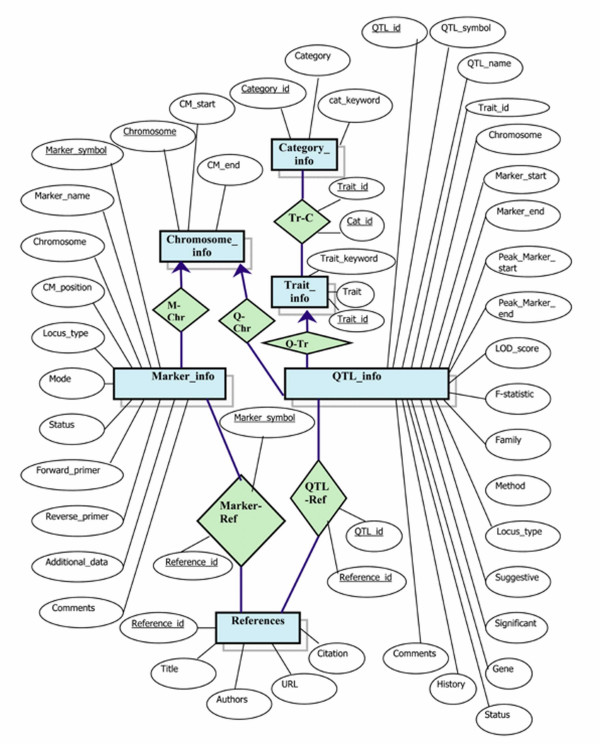
Entity-Relationship diagram of the integrated database. The integrated database consists of two major, linked divisions, the marker database, which is independent from the QTL database. This allows easy updating of either component of the database or potentially allowing the QTL database to be linked to multiple maps. QTL are characterized in terms of trait types, allowing QTL for similar phenotypes originally described with different terms to be linked by a single category. The markers can be linked to external databases such as NCBI via STS accessions. This will allow eventual direct browsing of genome annotations within QTL regions using Gbrowse.